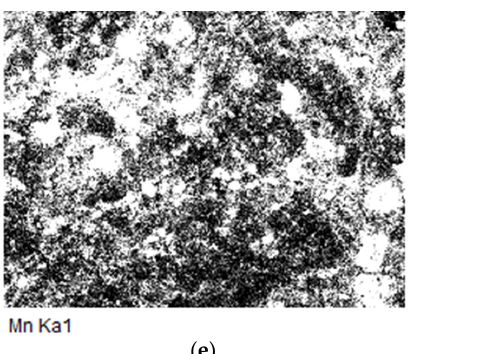
Figure 8. EDS analysis the fresh (Fe,Co,Mn)Ox material: ( a ) EDS spectrum; ( b ) electronic image of the (Fe,Co,Mn)Ox material; ( c ) EDS mapping of O; ( d ) EDS mapping of Fe; ( e ) EDS mapping of Mn; ( f ) EDS mapping of Co.